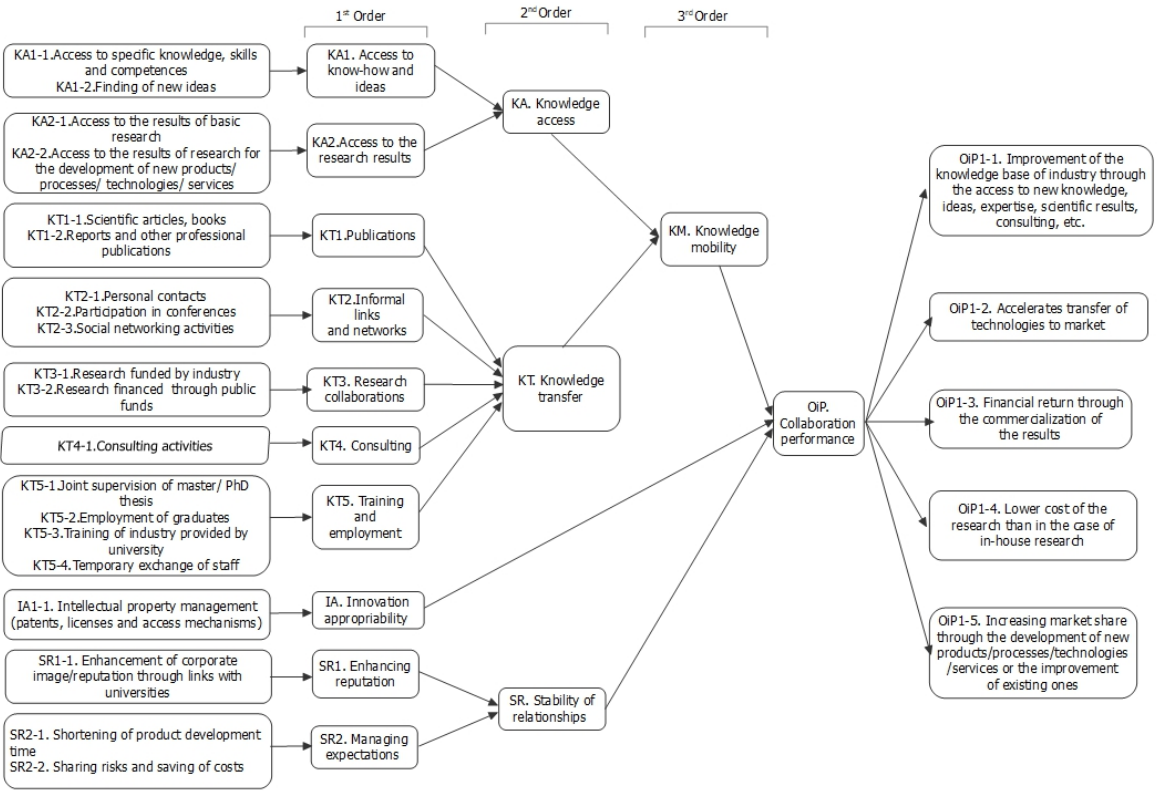
Figure 2. The proposed research model.